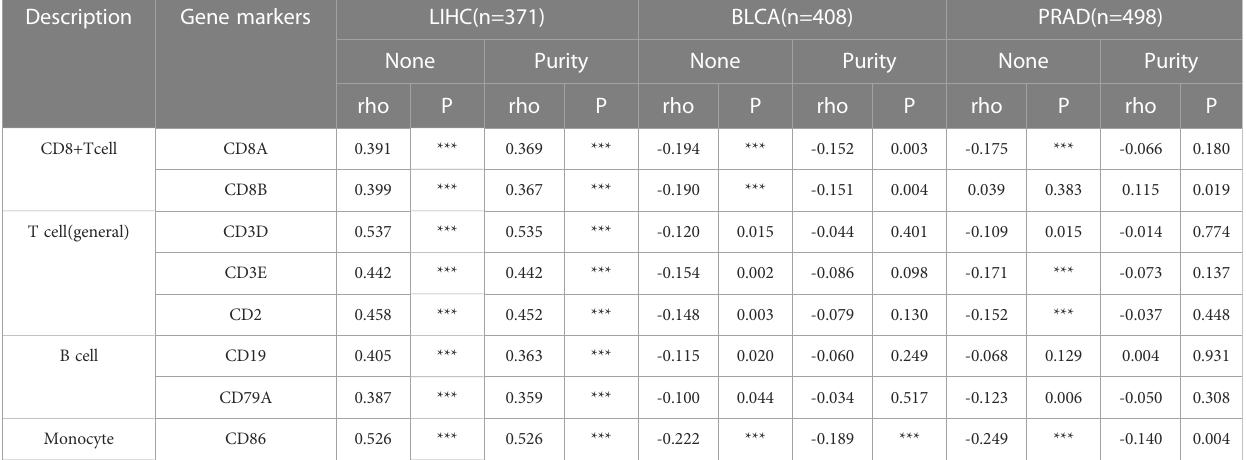
TABLE 1 Correlation analysis between FAM110A and related gene markers of immune cells in TIMER 2.0 (***P<0.001).